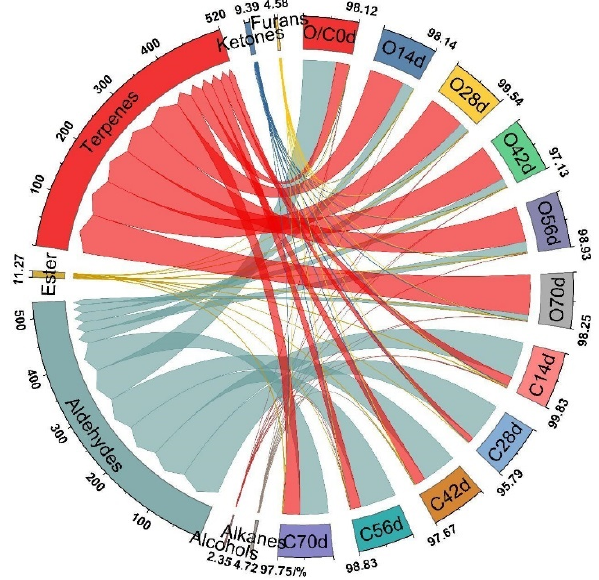
Figure 7. The relative contents of different types of aroma substances in the fruit under two method conditions. The groups represented by outside—inside in the ring graph were O/C0, O14, O28, O42, O56, O70, C14, C28, C42, C56, C70 d, respectively.